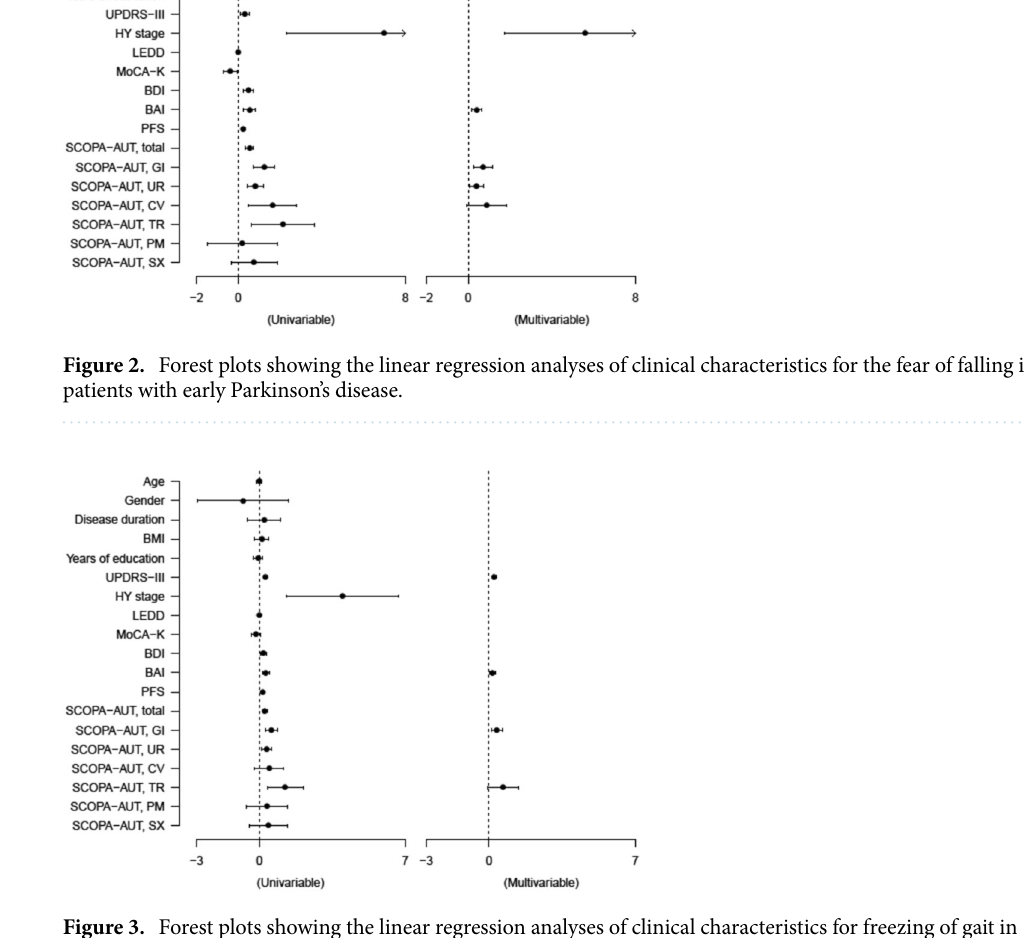
Figure 3. Forest plots showing the linear regression analyses of clinical characteristics for freezing of gait in patients with early Parkinson’s